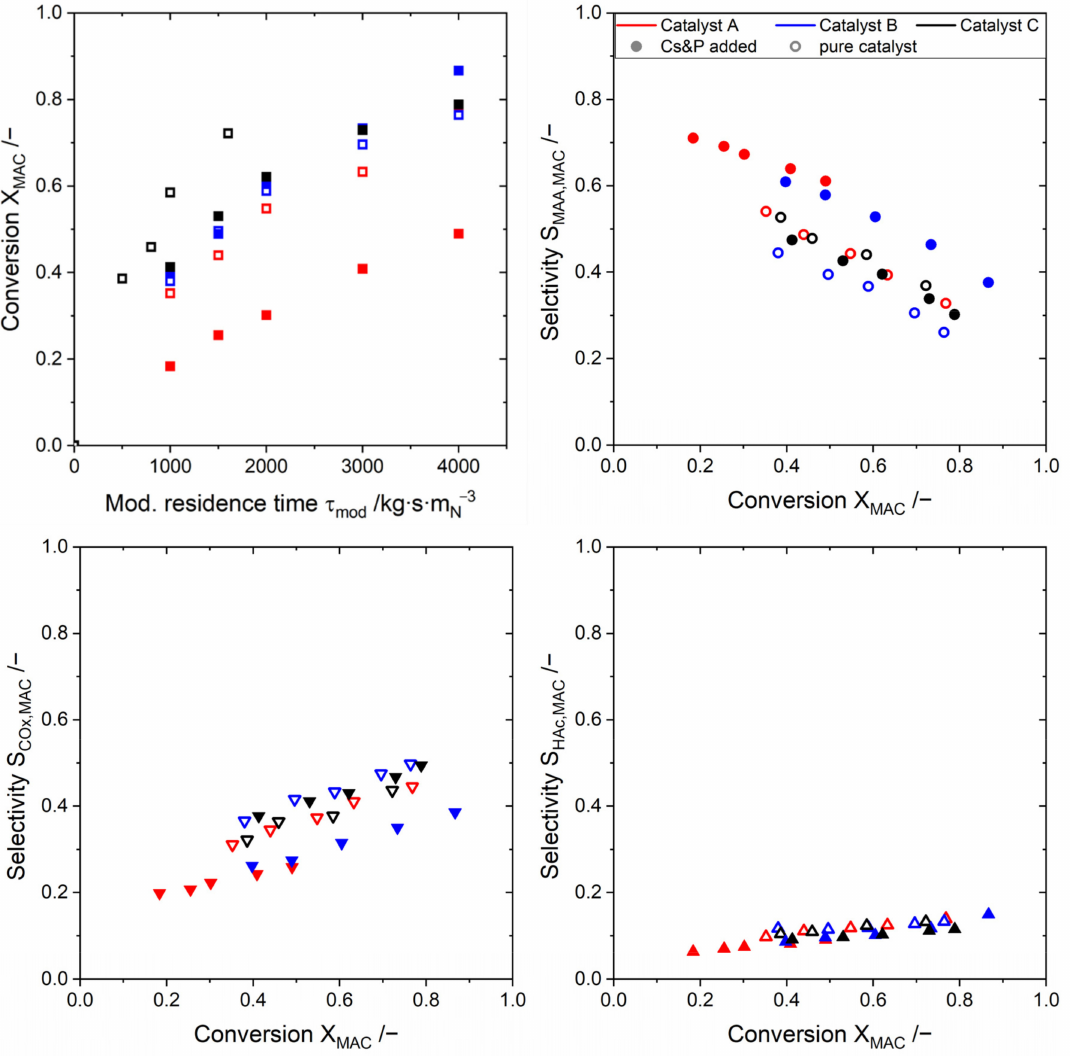
Figure 4. Catalytic performance of catalysts A, B and C at 300 ◦ C and 21% v/v water prior to (empty circle) and after adding Cs and P (filled circle) with (Mo + V + W)/P and (Mo + V + W)/Cs ≈ 18. MAC Conversion over the modified residence time ( top left ), MAA selectivity over MAC conversion ( top right ), CO x selectivity over MAC conversion ( bottom left ) and acetic acid selectivity over MAC conversion ( bottom right